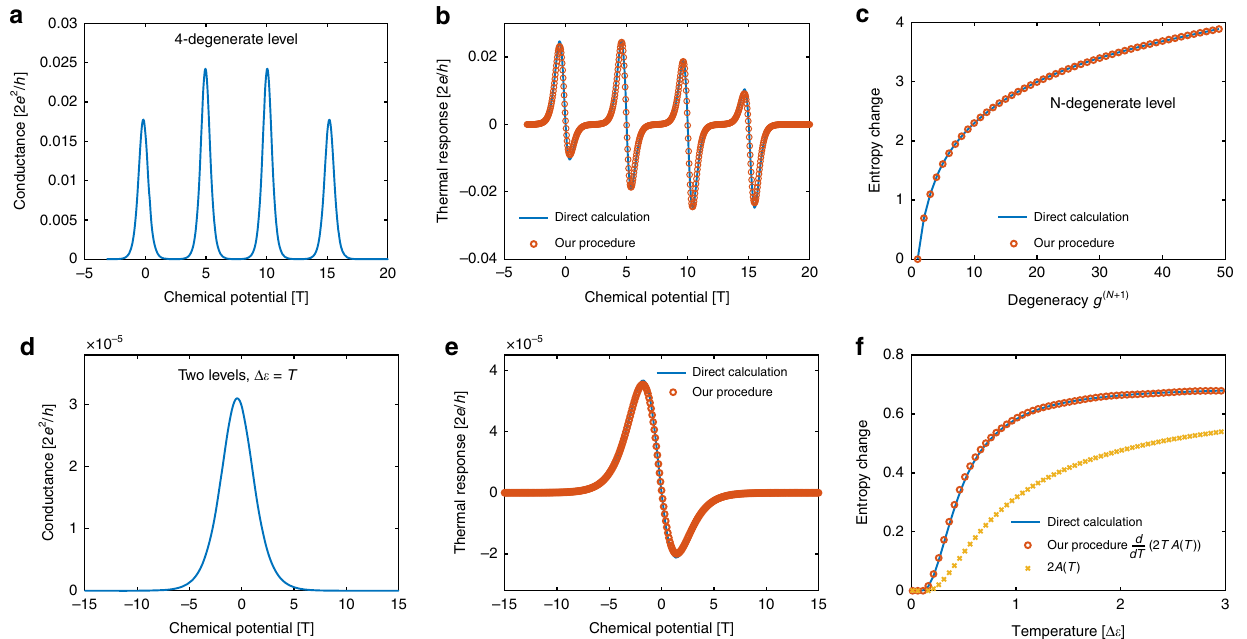
Fig. 1 Demonstration of the fi tting procedure. a , b Transport coef fi cients through a four-fold degenerate quantum dot, calculated via Eq. (1): a Conductance, b TR (solid blue line) with comparison to the derived expression [Eq. (4)] (red circles). The degeneracies for n ¼ 0 ; 1 ; 2 ; 3 ; 4-electron many-body states are g ð N Þ ¼ 1 ; 4 ; 6 ; 4 ; 1, respectively (Each peak was separately fi tted). c Entropy change between two valleys with fi rst valley degeneracy g ð N Þ ¼ 1, as a function of second valley degeneracy g ð N þ 1 Þ , calculated using the proposed procedure (red circles) compared to the exact result logg ð N þ 1 Þ (solid blue line). d – f Transport through a U ! 1 QD with 2 single-particle non-degenerate interacting levels, separated by Δ ϵ ¼ T , calculated via Eq. (1): d Conductance, e TR (solid blue line) with comparison to the derived expression [Eq. (4)] (red circles). f Entropy change between the two valleys as a function of temperature. Direct thermodynamic calculation of entropy change (solid blue line) is compared to our procedure ( d 2 T ´ A ð T Þ = dT ) (red circles). A ð T Þ is shown as yellow crosses.